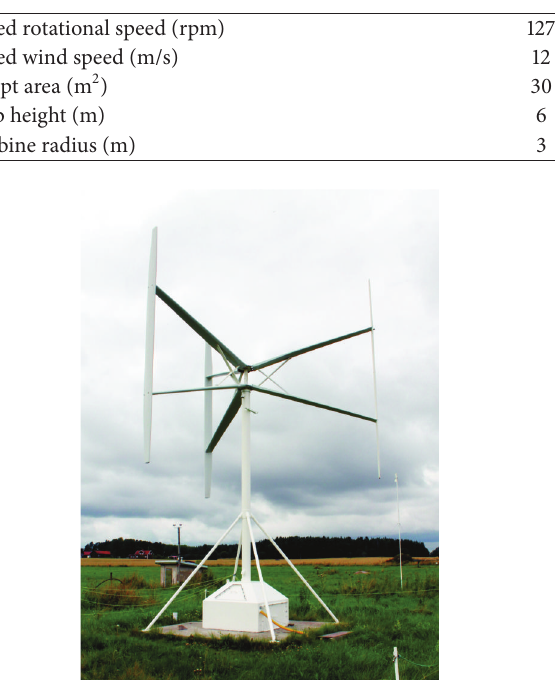
Figure 1: 12kW vertical axis wind turbine designed and constructed at Uppsala University.